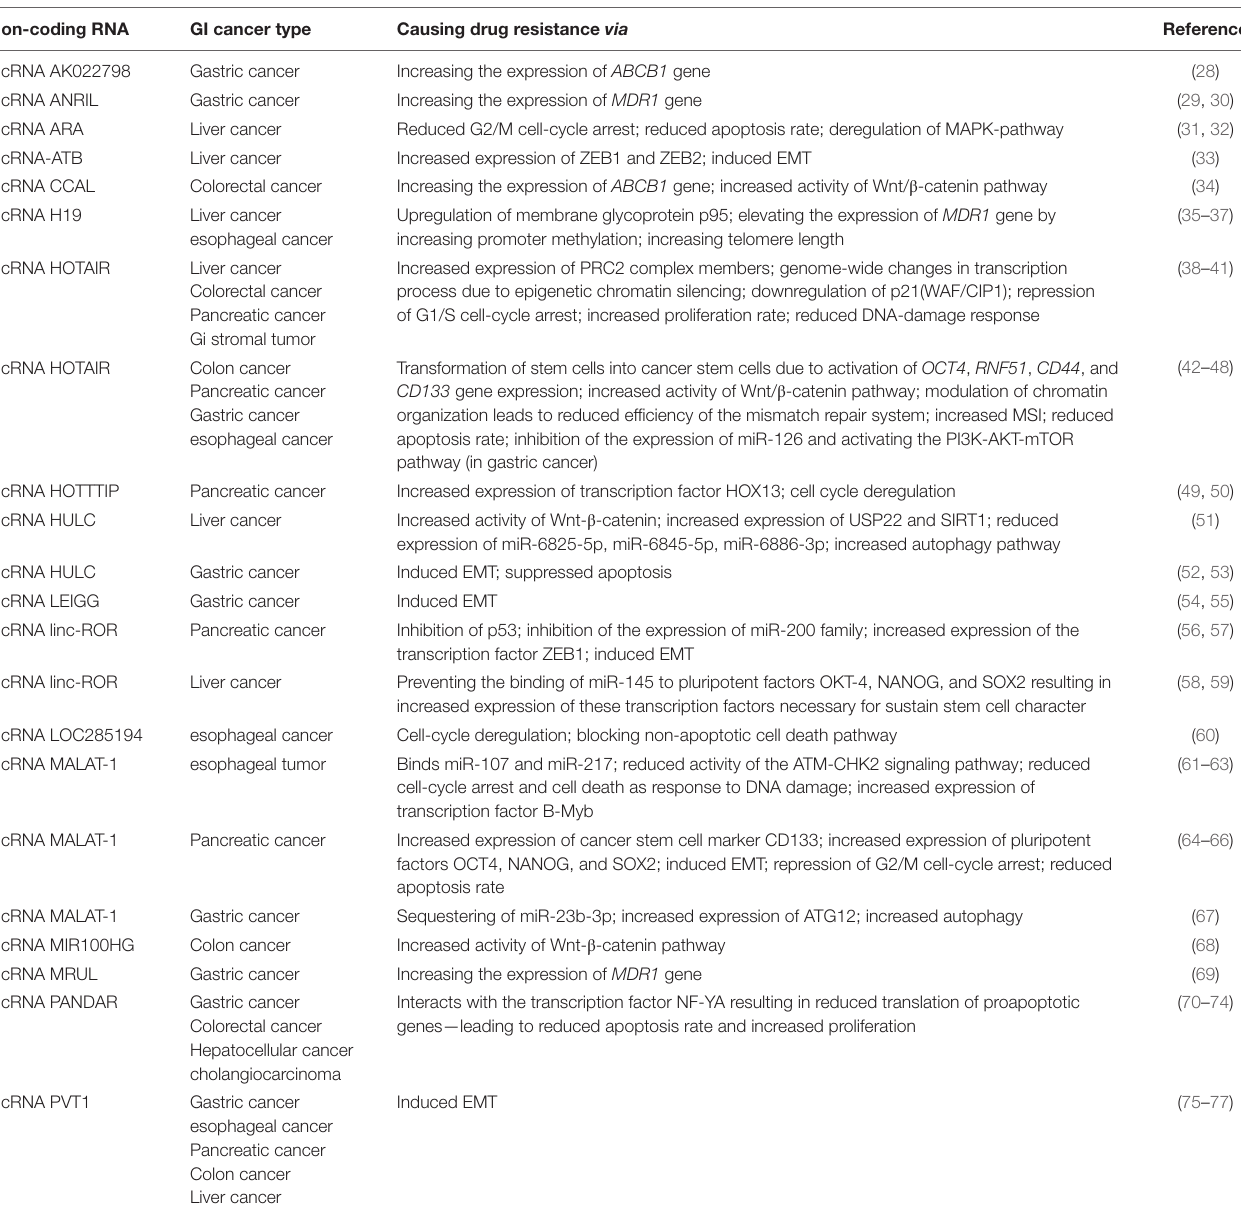
TAble 1 | Overview about non-coding RNAs involved in resistance to anticancer drugs in gastrointestinal tumors. Non-coding RNA